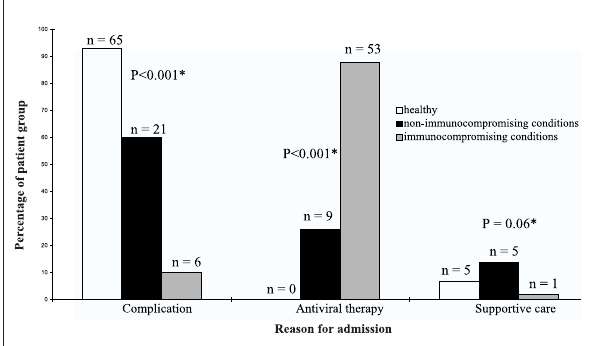
tients (Table 2). Skin and soft tissue infections, joint infec- tions, and neurological, pulmonary and hepatic complications